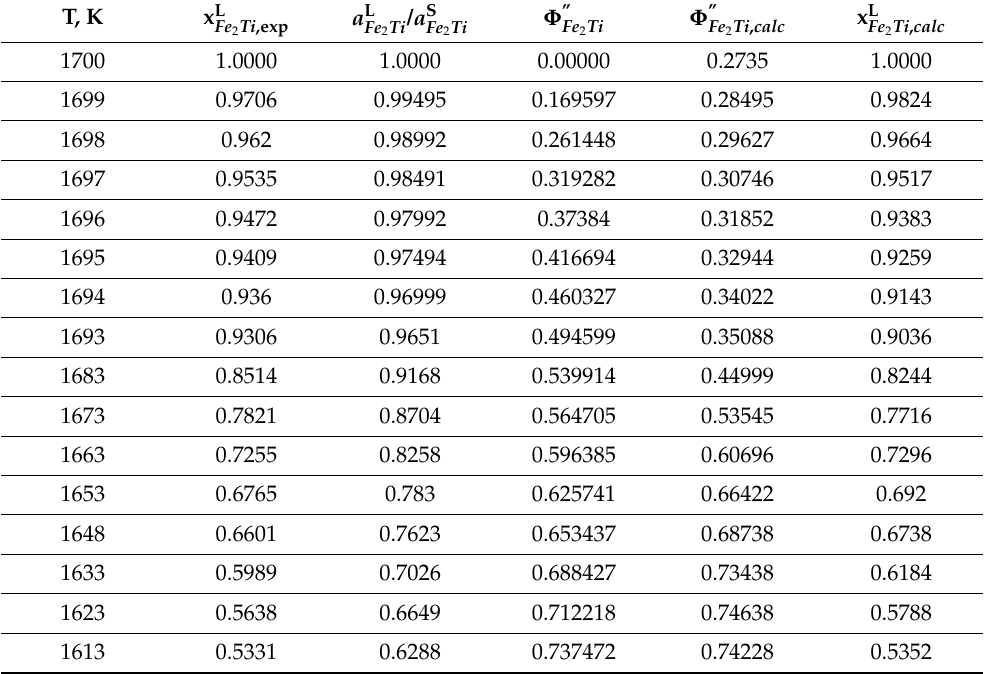
Table4describesthecomparativeexperimentalandcalculateddatafor Equations (4) and (5), and the variance of convergence is 0.0083. Table 4. The comparative experimental and calculated data of the Fe 2 Ti crystallization region using Fe 2 Ti-Ti